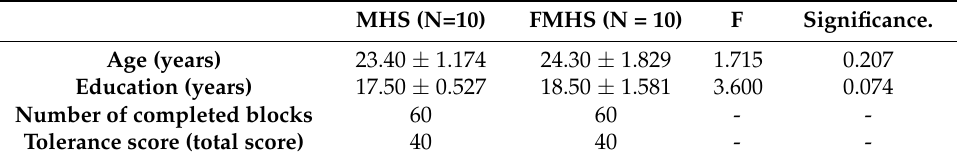
Table 1. One-way analysis of variance (ANOVA) of male and female healthy